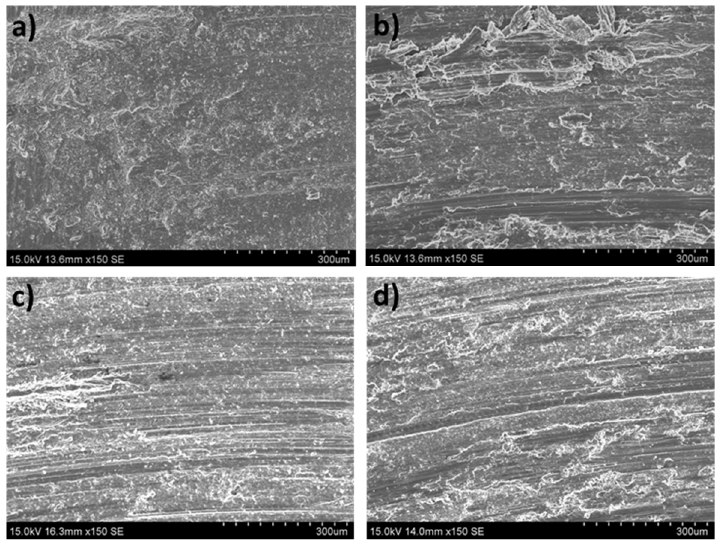
Figure 10. Worn tracks observed for the peak-aged ZX30 alloy under the different wear conditions: ( a ) 2 N, 0.05 m s − 1 ; ( b ) 20 N, 0.05 m s − 1 ; ( c ) 2 N, 0.1 m s − 1 ; ( d ) 20 N, 0.1 m s − 1 .